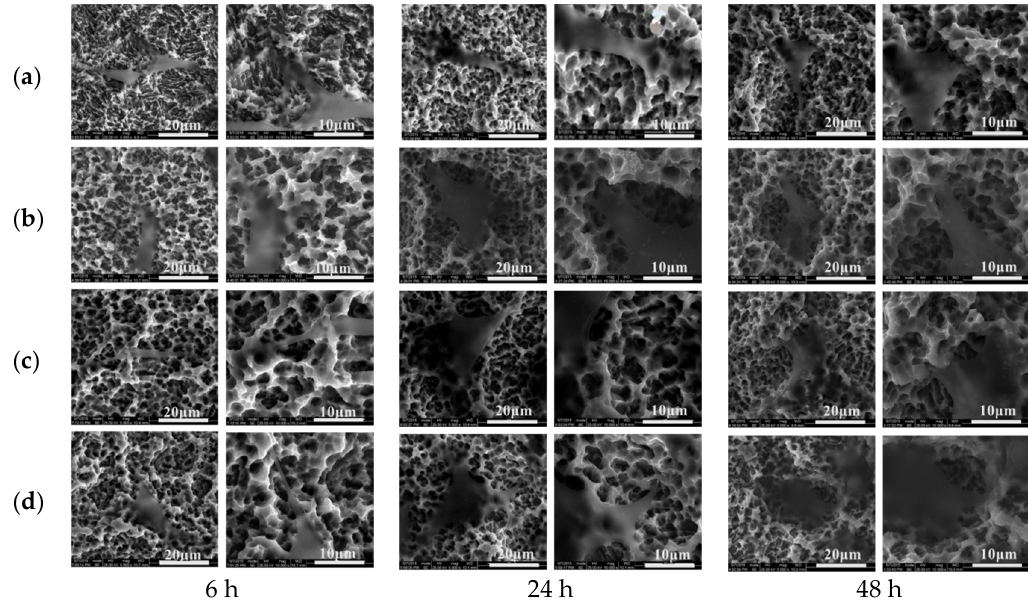
Figure 8. The structures of osteoblasts on the Ti surfaces of four groups as measured by SEM at 5000 × and 10,000 × after 6, 24, and 48 h of culture: ( a ) SLA sample; ( b ) SLA / NaOH-10s sample; ( c ) SLA-PECVD / NaOH-10s sample; and ( d ) SLA-PECVD / NaOH-10d sample.